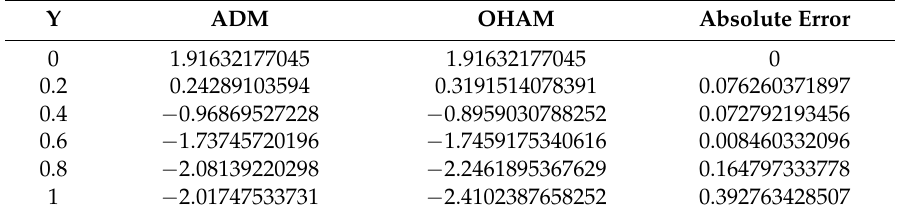
Table 4. The comparison of ADM and OHAM methods for the temperature profile, when W e = 0.1, m = 0.01; M = 0.1, ω = 0.02, t = 0.6, Ec = 10, Pr = 4.0,C 1 = − 0.0009350828,C 2 = −